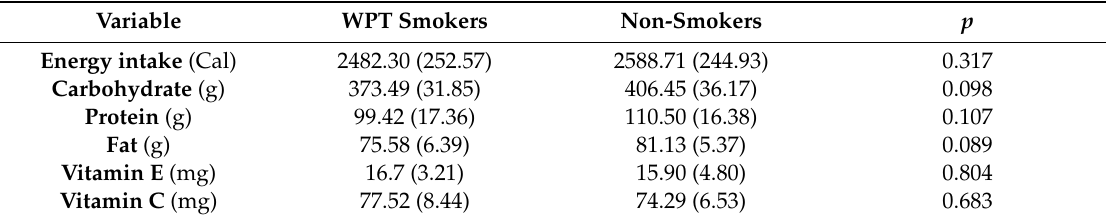
Table 2. Dietary information during the week prior to testing of WPT smoker and non-smoker young women.